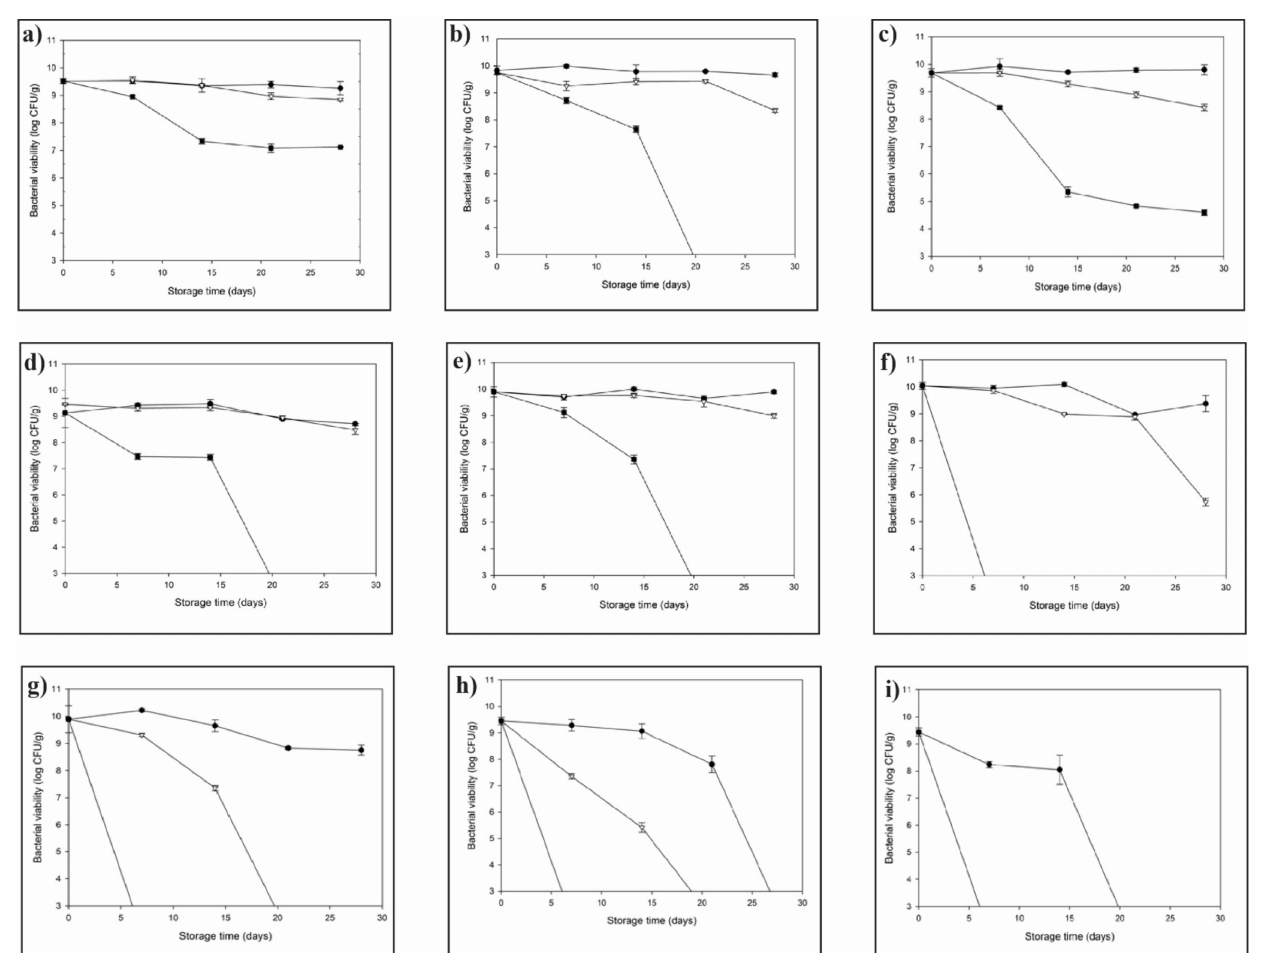
Figure 1. The storage stability of fluidized bed-dried Lactobacillus paracasei powders embedded in whole milk powder matrix with ( a ) a w 0.3, ( d ) a w 0.4, ( g ) a w 0.5; skim milk powder matrix with ( b ) a w 0.3, ( e ) a w 0.4, ( h ) a w 0.5; milk protein isolate matrix with ( c ) a w 0.3, ( f ) a w 0.4, ( i ) a w 0.5. The viability is expressed as the logarithmic values of survival against a storage time of 4 weeks at 4 ◦ C (black circle), 25 ◦ C (white triangle), and 37 ◦ C (black square). Error bars represent the standard deviation of means ( n ≥